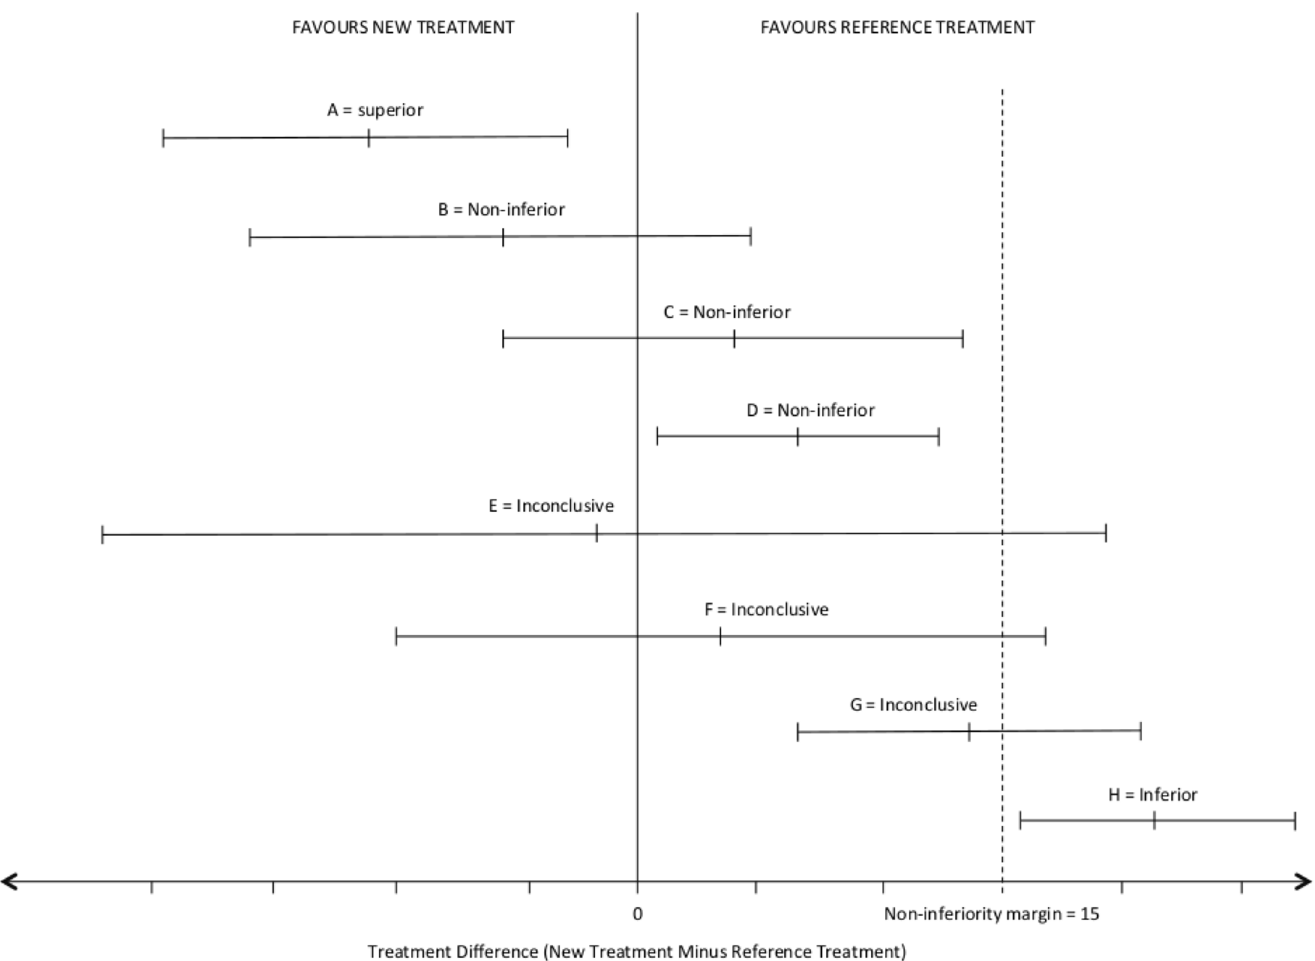
Fig 1. Possible scenarios of treatment differences and interpretation of non-inferiority results. Error bars indicate two sided (1 – 2 α ) x 100% confidence intervals, where α is the Type I error rate. The zone of non-inferiority is to the left of the non-inferiority margin. Scenario A, new treatment is superior as the CI lie to the left of zero. Scenarios B and C, new treatment is non-inferior but not superior as the CI lie to the left of the non-inferiority margin and include zero. Scenario D, represents an unusual circumstance in which the new treatment is both non-inferior (as defined by the non- inferioirty margin), and inferior (as defined by exclusion of the null treatment difference). This can result from a very large sample size, or a non-inferiority margin that is too wide. Scenarios E and F, the difference is non-significant but non-inferiority is inconclusive. Scenario G, represents a significant result but non-inferioirty is inconclusive. Scenario H, inferior as the CI lie to the right of the non-inferiority margin. Adapted from Piaggio et al 2012 and 2006 [41,